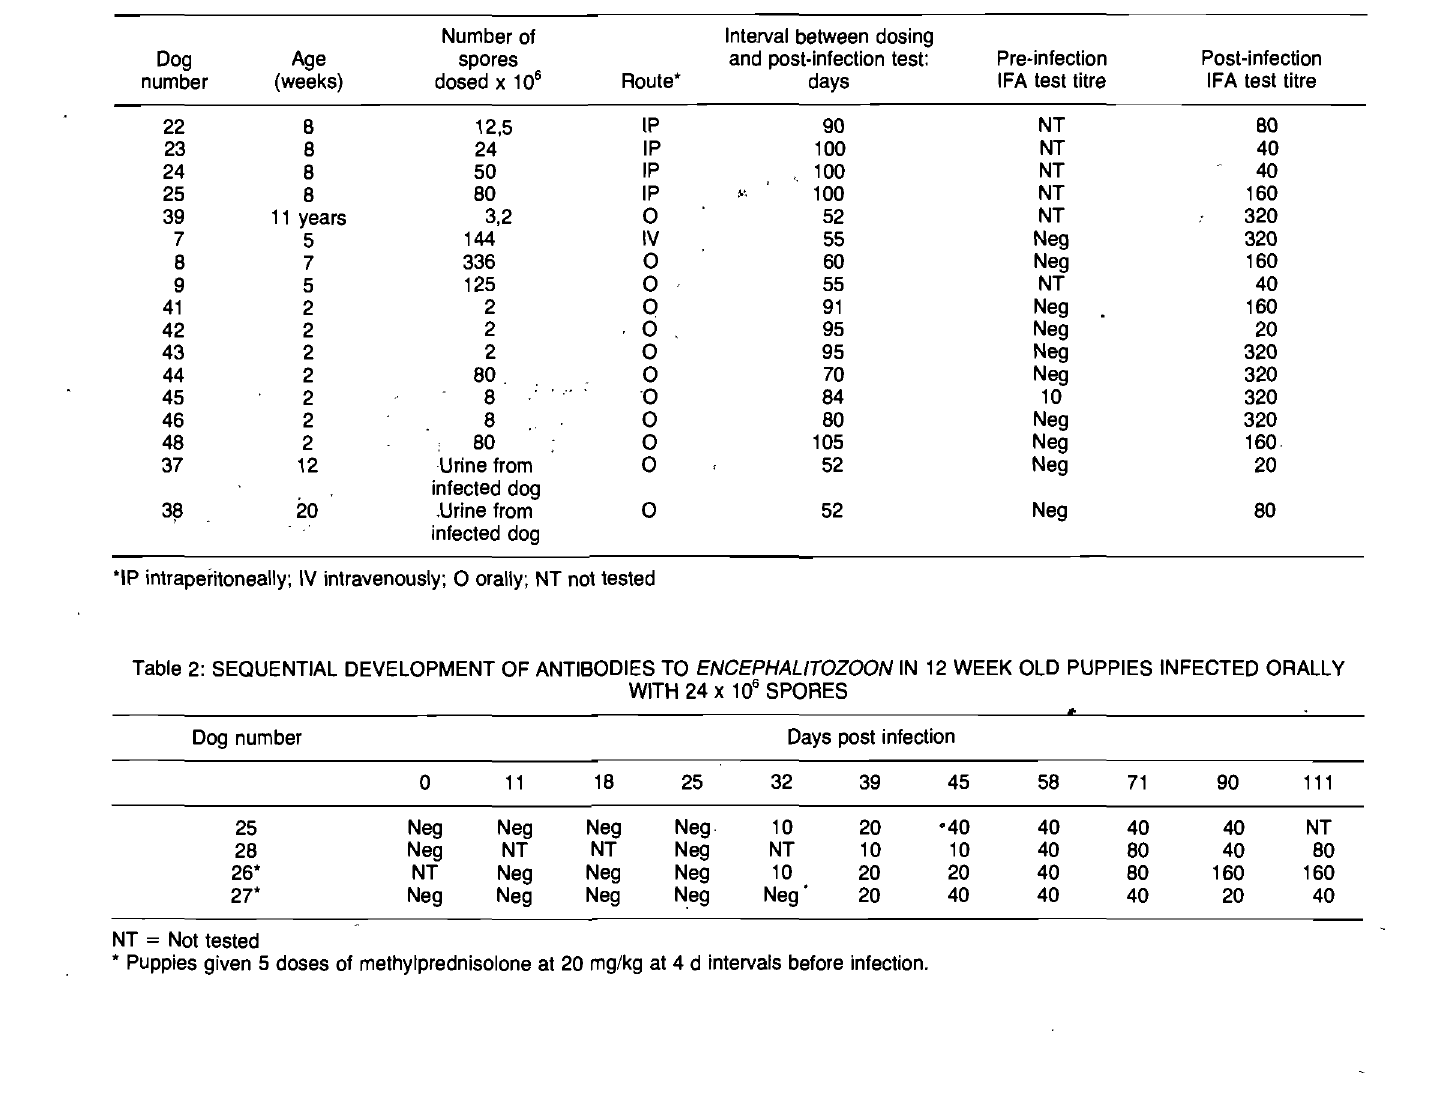
Post-infection Dog Age spores and post-infection test: Pre-infection IFA test titre IFA test titre number (weeks) dosed x 10 6 Route* days